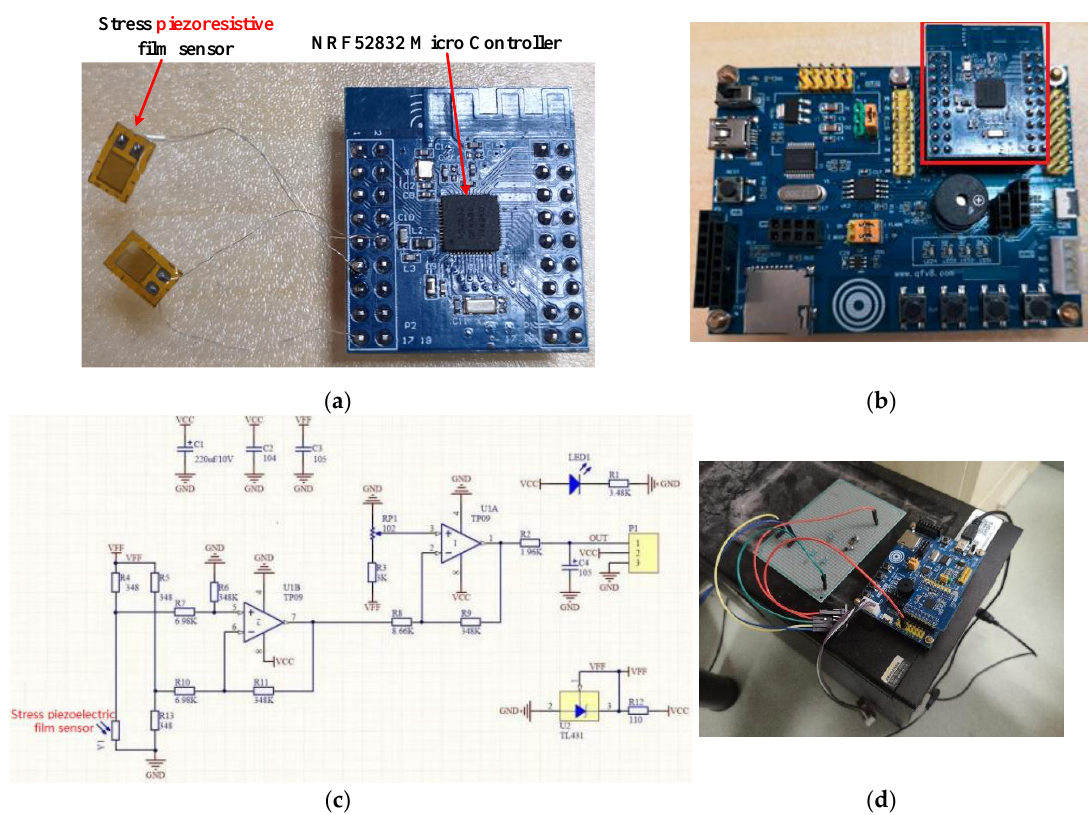
Figure 8. ( a ) Pressure signal acquisition module; ( b ) test board for a microcontroller circuit board (the microcontroller circuit board is indicated by a red rectangle); ( c ) electric schematic diagram of the pressure signal acquisition module; ( d ) prototype system connected with the server.